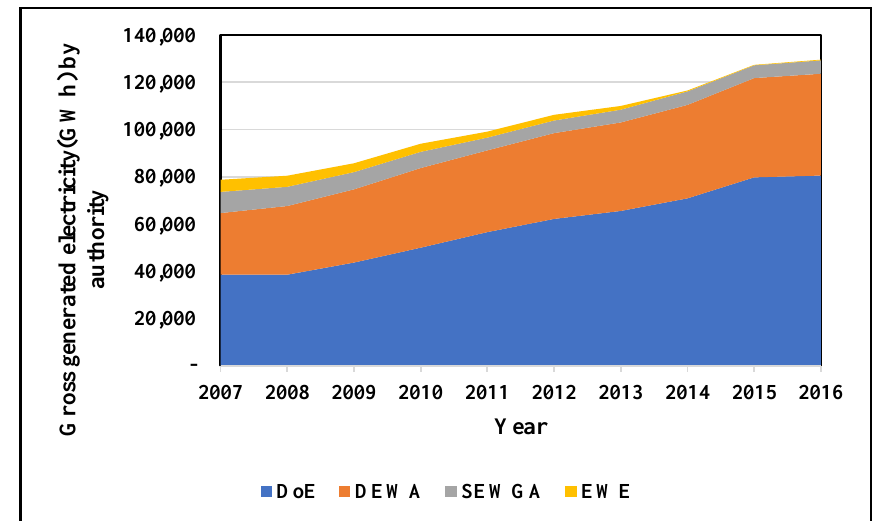
Figure 15. Gross generated electricity (GWh) by authority [81].